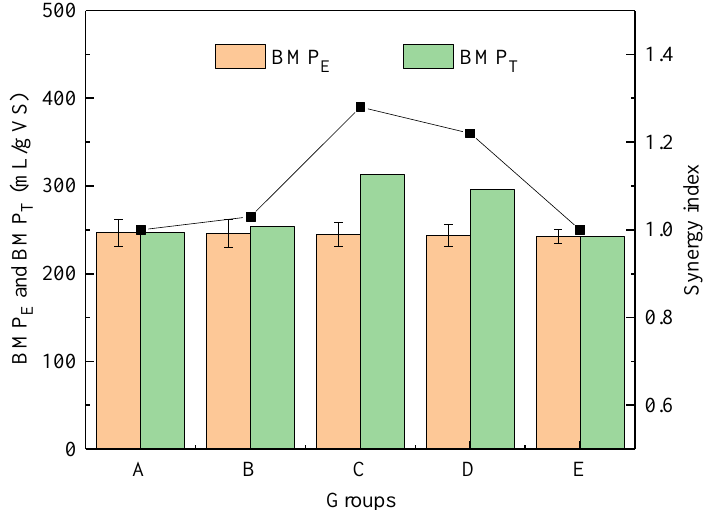
Figure 4. Comparison among BMP T , BMP E , and synergy index of the BMP tests (the mixing ratios of kitchen waste and blackwater based on TS content in groups A–E are 4:0, 3:1, 1:1, 1:3, and 0:4, respectively).